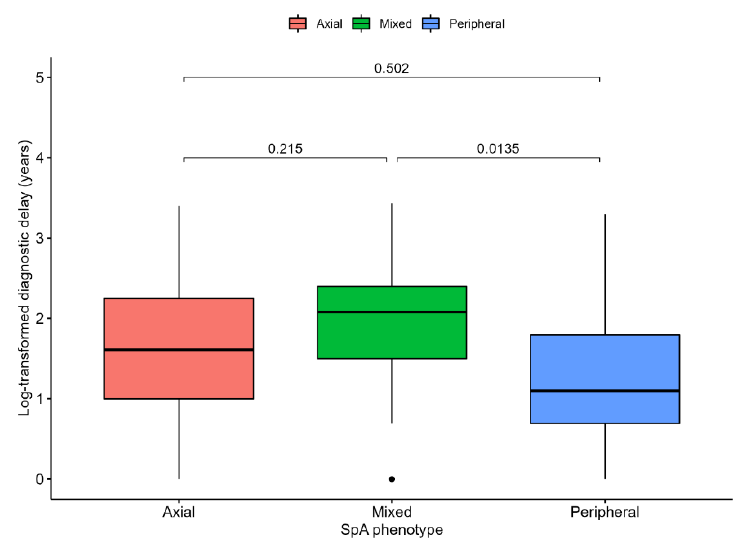
Figure 1. Diagnostic delay from symptom onset to disease diagnosis expressed in years and log- transformed (y axis is transformed to reflect a priori values) compared across spondylarthritis phenotype. ANOVA test p value = 0.016. p -values for comparison are shown and are based on Tukey’s post hoc tests. Table 1. Baseline comparison of patients with ankylosing spondylitis and psoriatic arthritis treated with secukinumab including both first- and second-line